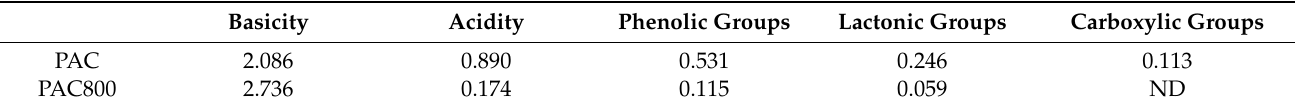
Table 2. Results of titration